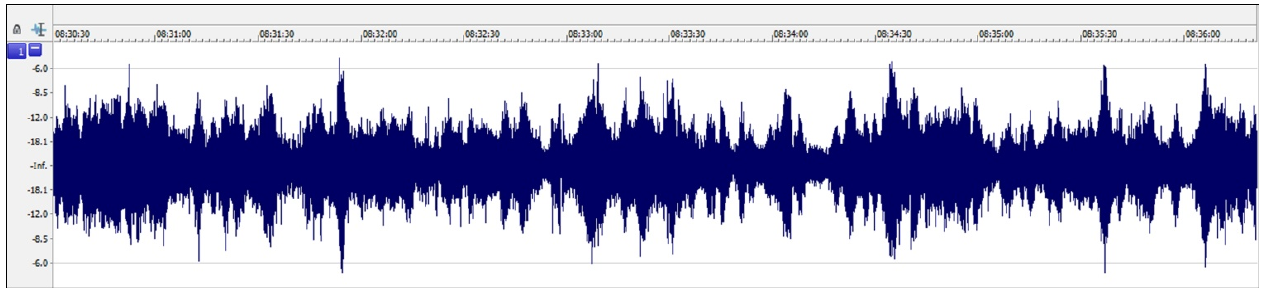
Figure 6 . Soundscape map, 8:30 a.m.–9:30a.m., 23 August 2013 (53°18'10.1"N 2°58'00.9"W).